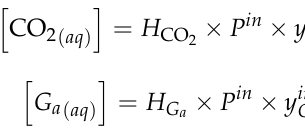
Figure 2. Experimental setup for CO 2 absorption using series of membrane contactors. Table 1. Data for X-40 and X-50 2.5” X 8” Liqui-Cel ® Extra-flow contactor modules as provided by manufacturers [34].